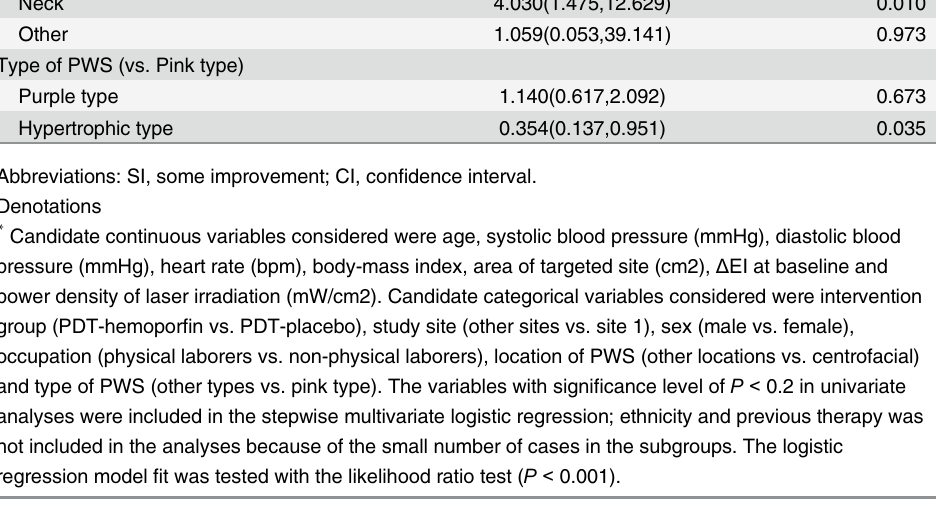
Table 3. The logistic regression analysis to identify factors relevant to achieving at least SI at week 8 * . Variables Estimated Odds Ratio (95% CI) P value PDT-hemopor fi n vs. PDT-placebo 29.324(16.490,54.244) < 0.001 Location of PWS (vs. Centrofacial)